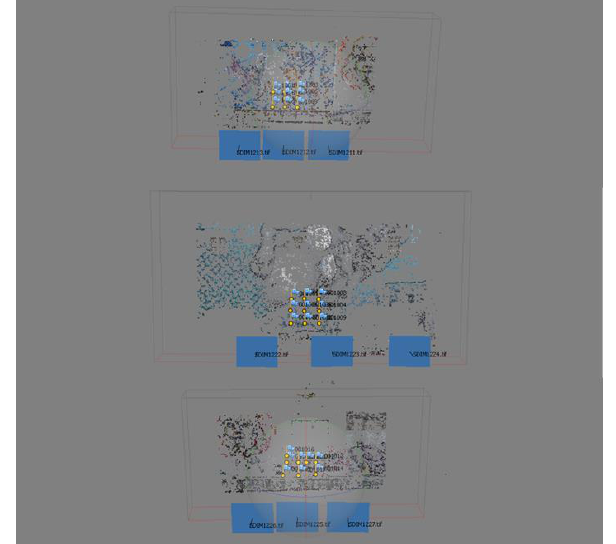
Figure 4: Capture plan of images as is shown from the UI of